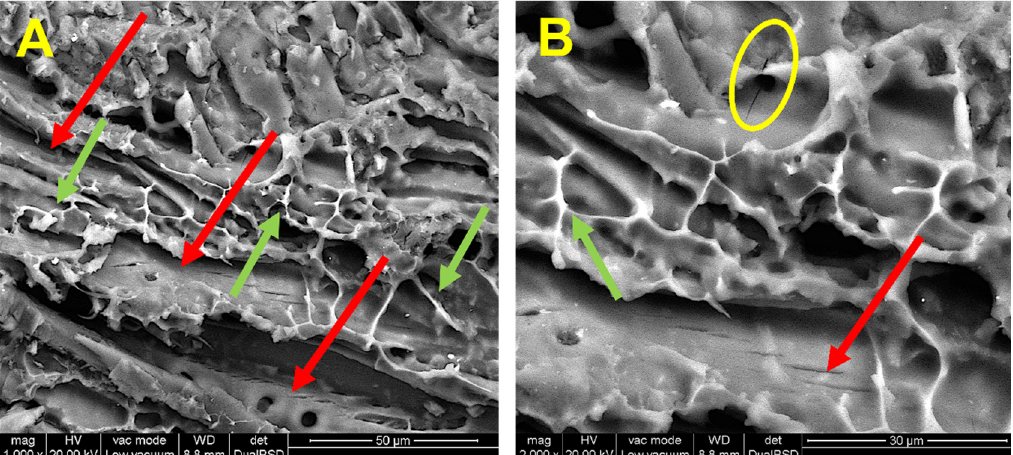
Figure 7. Scanning electron microscopy images of particleboard glued with 15% of adhesive formulation. Different magnifications of the same representative area are proposed: ( a ) 1000× ( b ) 2000×. Red arrows identify the wooden matrix; green arrows identify the tannin-furfural adhesive.